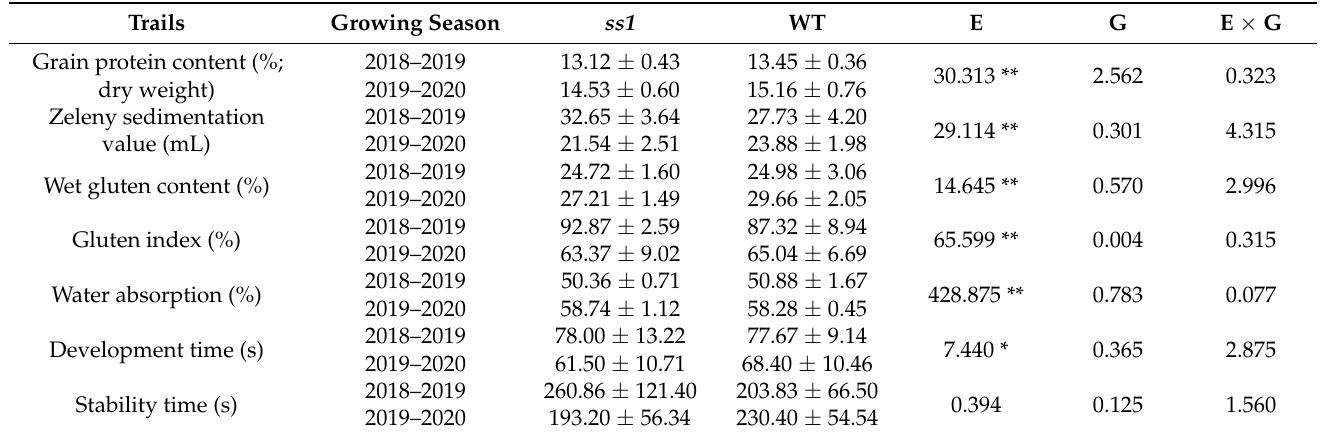
Table 2. Comparison of the processing quality parameters of the mutant ss1 and the wild-type (WT) control.